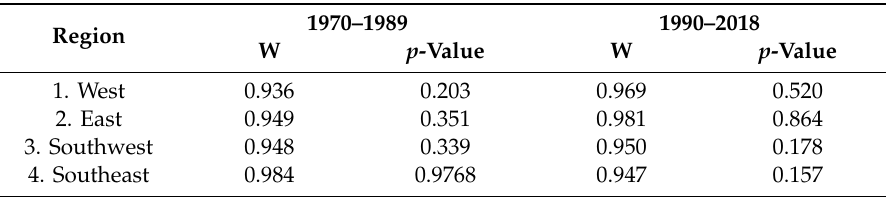
Table 1. Results of the Shapiro–Wilk test.